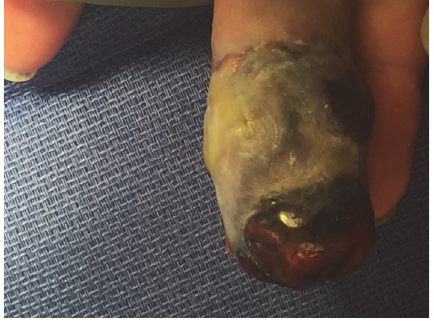
Figure 6: ADPA lesion prior to amputation, palmar view.